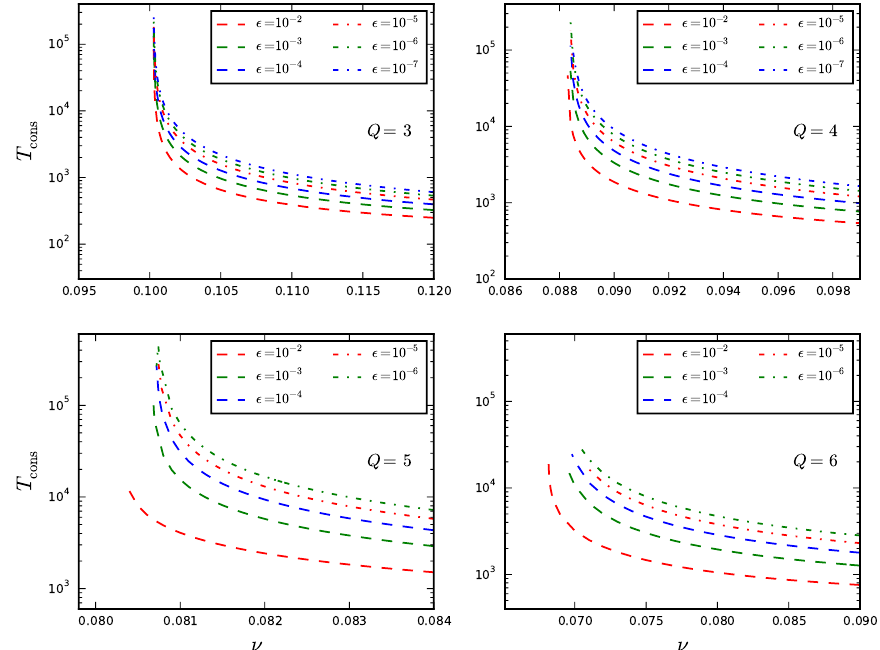
Figure 9. Time to consensus in the PPM with Q >